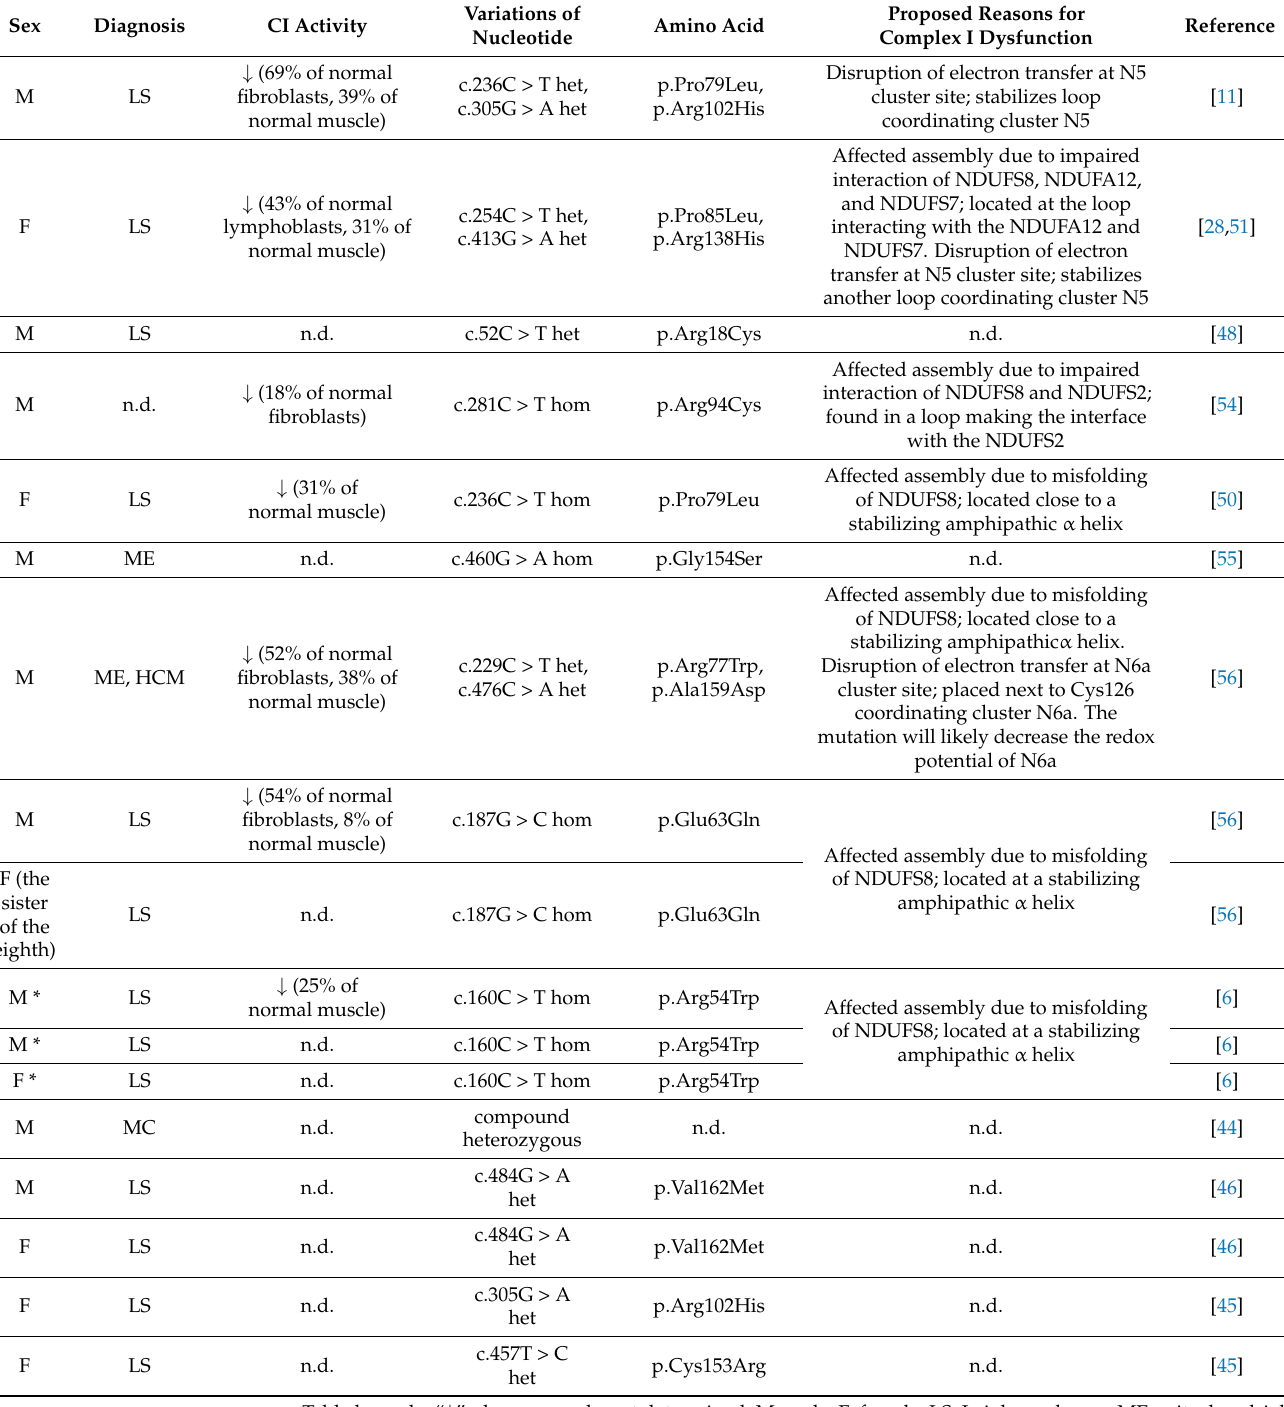
Table legends: “ ↓ ”: decrease; n.d.: not determined; M: male; F: female; LS: Leigh syndrome; ME: mitochondrial encephalopathy; HCM: hypertrophic cardiomyopathy; MC: mitochondrial cytopathy; CI activity: the proportion of complex I activity in patients with Leigh syndrome to control groups; het: heterozygous; hom: homozygous; NDUFA12: NADH dehydrogenase (ubiquinone) 1 alpha subcomplex 12; NDUFS7: NADH:ubiquinone oxidore- ductase core subunit S7; NDUFS2: NADH:ubiquinone oxidoreductase core subunit S7; N5: one of the FeS clusters in NDUFS1; N6a: one of the two FeS clusters in NDUFS8. * The three patients from Marina et al. [6] are all the children of the consanguineous Afghan parents ordered by